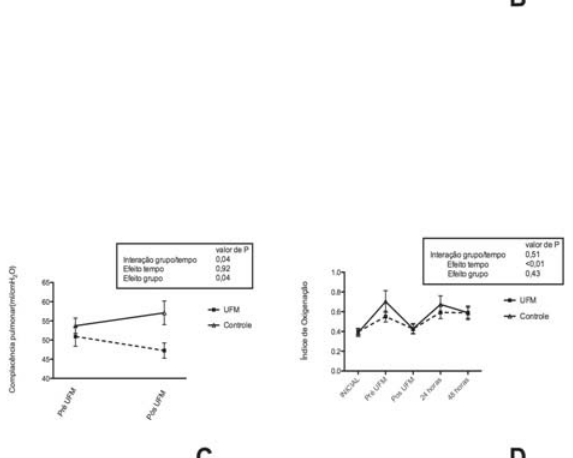
Fig. 3 - Variáveis de mecânica respiratória e índice de oxigenação. Análise de variância com dois fatores para medidas repetidas. Valores expressos em média e dois erros padrão da média. (A) diferença alvéolo-arterial, (B) resistência de vias aéreas, (C) complacência pulmonar, (D) índice de oxigenação